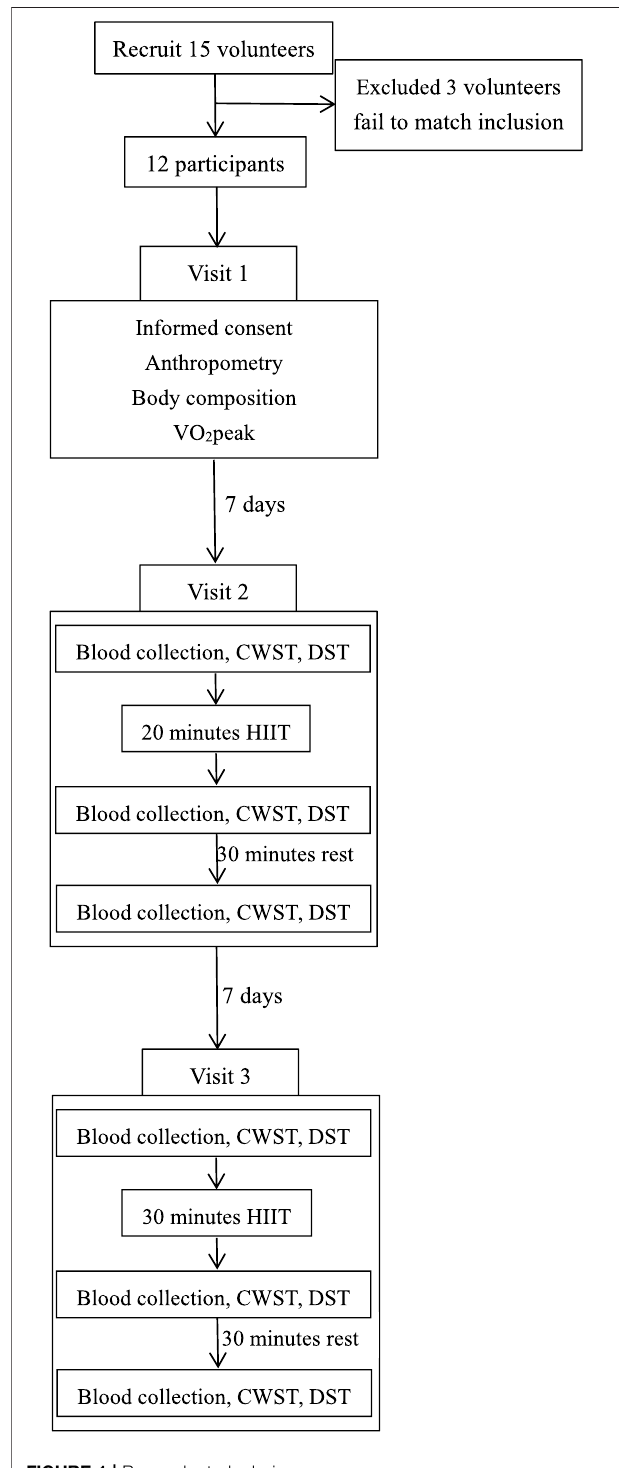
FIGURE 1 | Research study design.